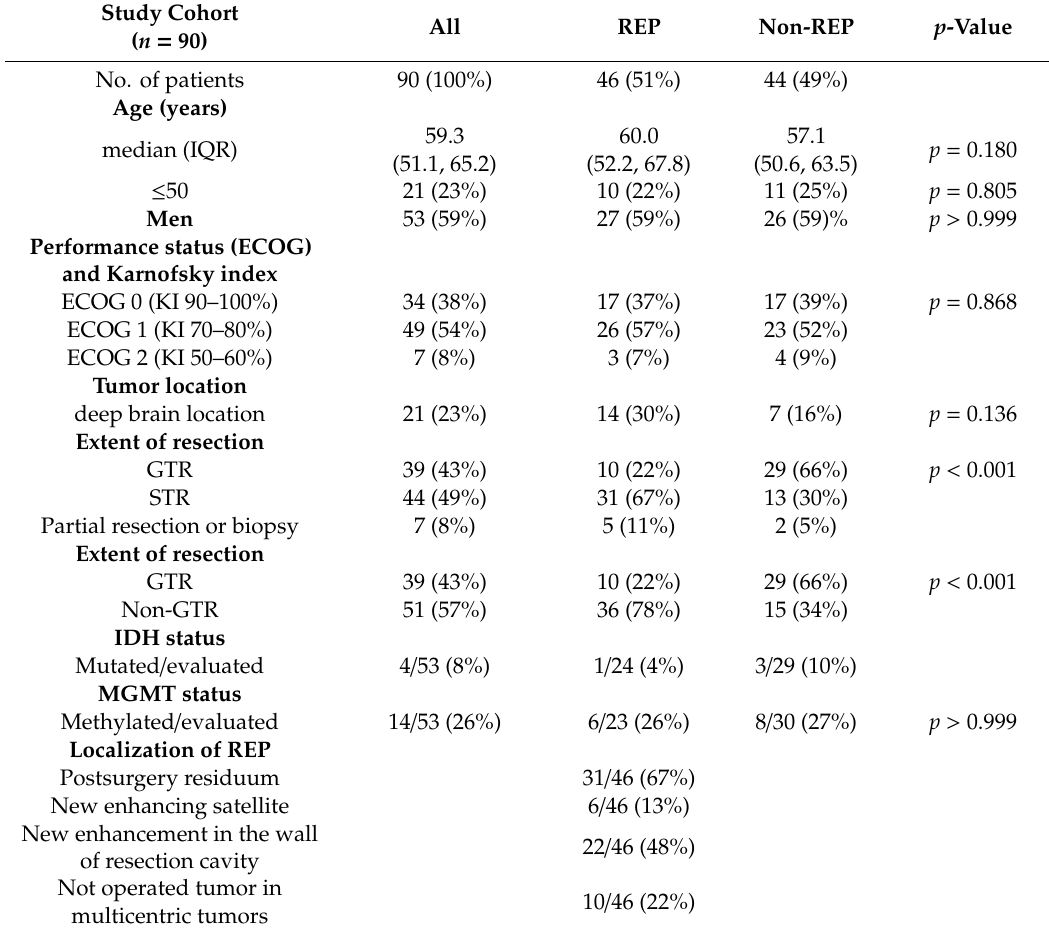
Table 1. Basic patients’ characteristics of cohort with REP and